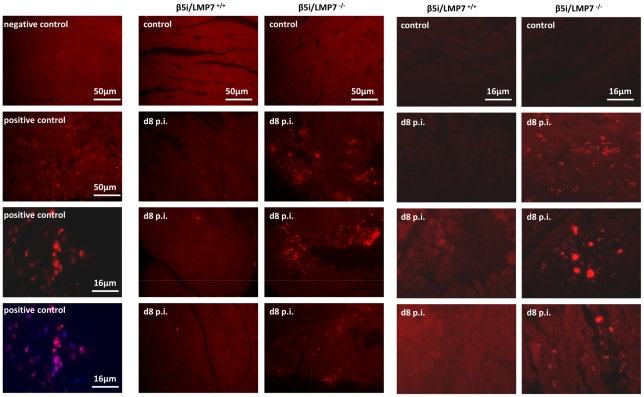
IP-deficient hearts are prone to apoptotic cell death.Apoptosis was assessed in vivo in cardiac tissue sections in naive and CVB3-challenged mice (d8 p.i.) by in situ cell death detection kit, TMR red. Representative cardiac sections from two independent experiments (infection of n = 5 mice / experiment) are shown. Left panels: controls - upper two slides from first experiment, lower two slides with positive controls from second experiment illustrating DNA strand breaks in inflammatory lesions and surrounding cardiomyocytes, which colocalize to nuclei (merge with Hoechst staining). More information is provided in Fig. S5 + 6 to this figure.